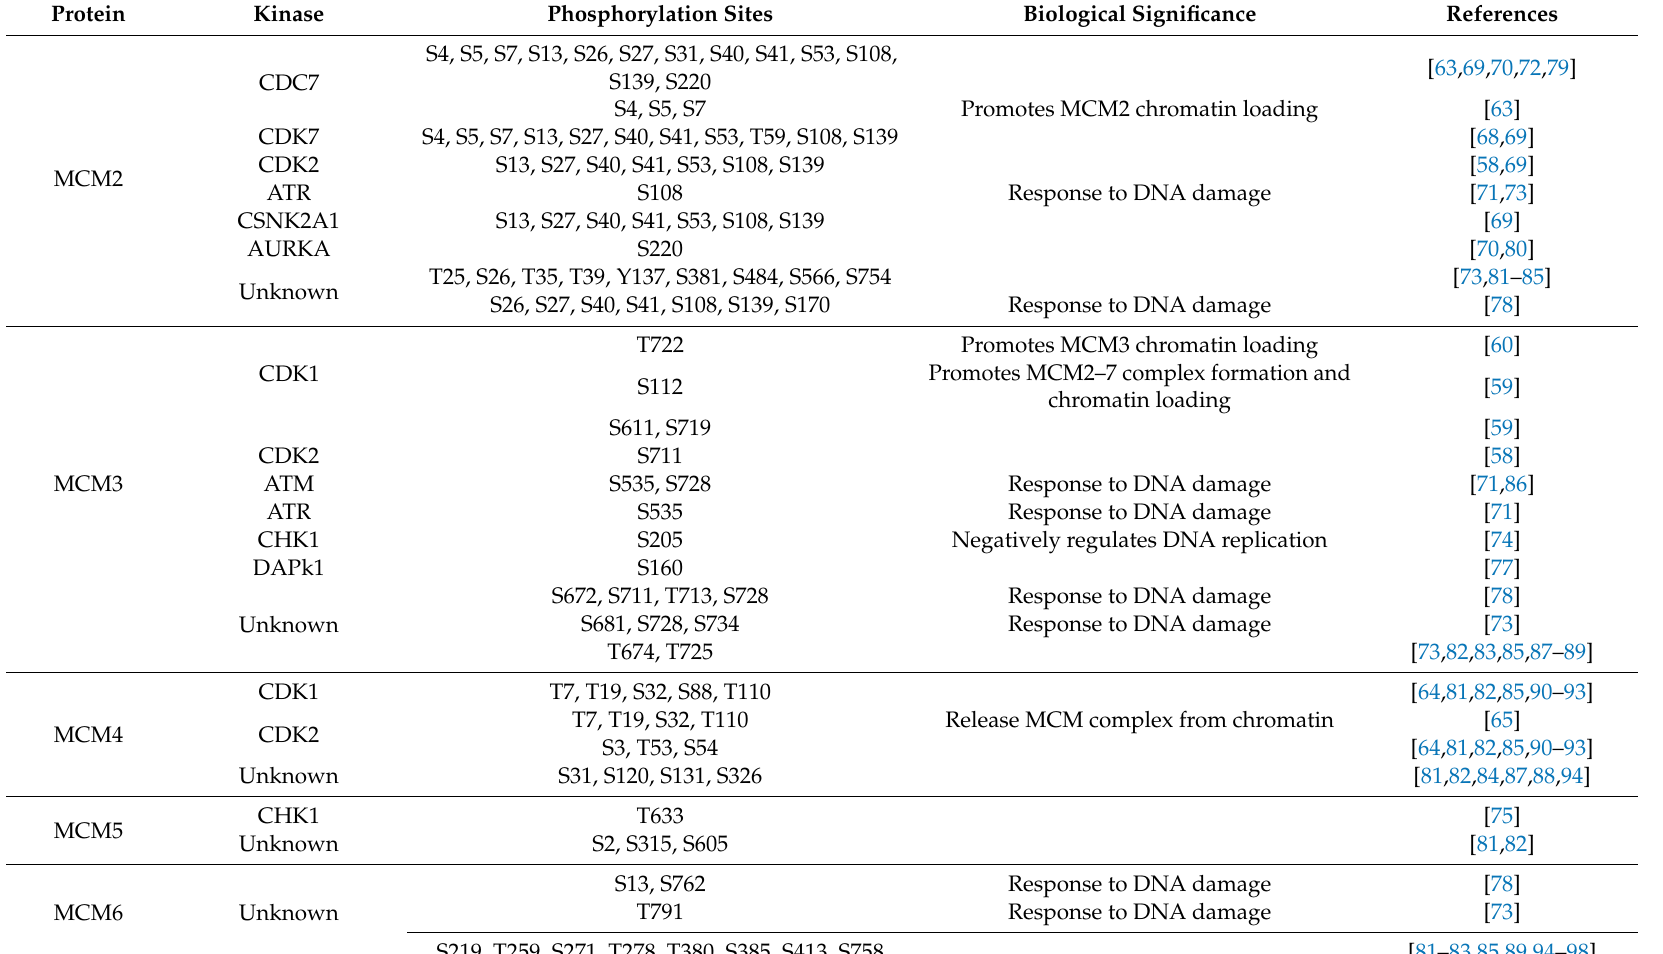
Table 3. MCM phosphorylation sites in human cancer